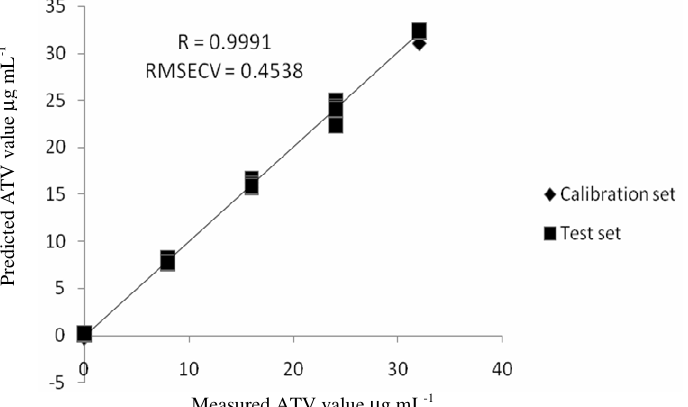
Figure 3. Predicted values versus measured ATV values for siPLS model, using intervals